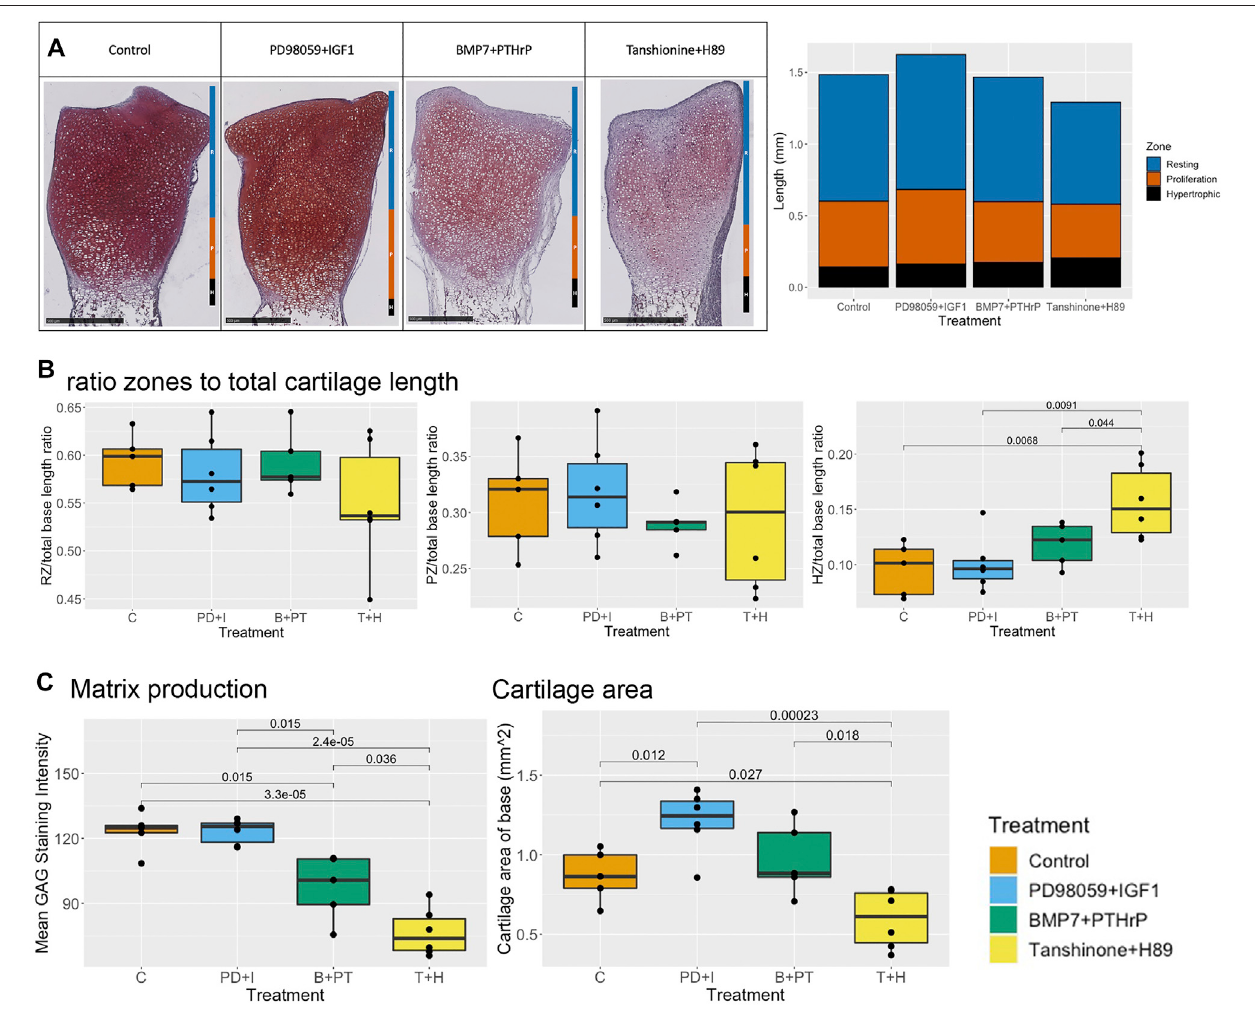
FIGURE 7 | Histological analysis of zonal length, ratio of zones to total cartilage length, proteoglycan production and cartilage surface area in base of rat pups metatarsals (A) . Representative Safranin O stained sections of control, PD98059 (ERK inhibitor) +IGF1, BMP7+PTHrP and Tanshinone IIA (DLX5 activator)+H89 (PKA inhibitor) treated rat pups metatarsals at day 6 (left) and comparison of size of resting zone, proliferative zone and hypertrophic zone of stained samples (right) (B) . Comparison of ratio of size of resting zone (left), proliferative zone (middle) and hypertrophic zone (right) to total cartilage length of base of metatarsals (C) . Comparison of matrix production and cartilage surface area, Welch Two Sample t -tests were performed and differences were considered signi fi cant when p < 0.05.